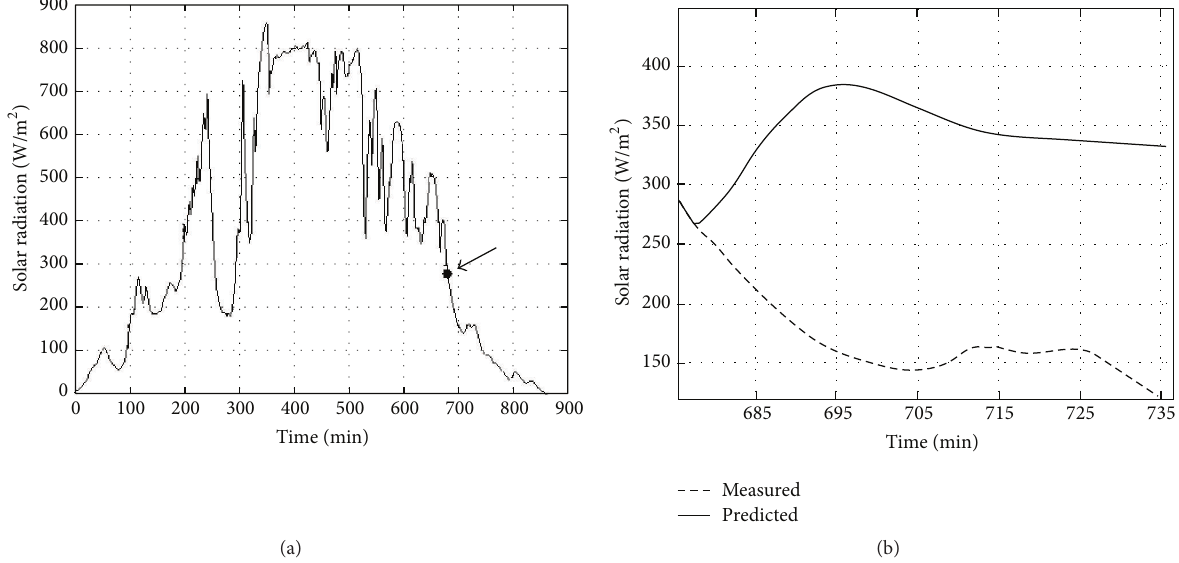
Figure 5: In (a), the solar radiation measured at the 8 of July of 2001. In (b), the solar radiation sixty-step ahead prediction, from the point identified in (a), using a 10th order AR